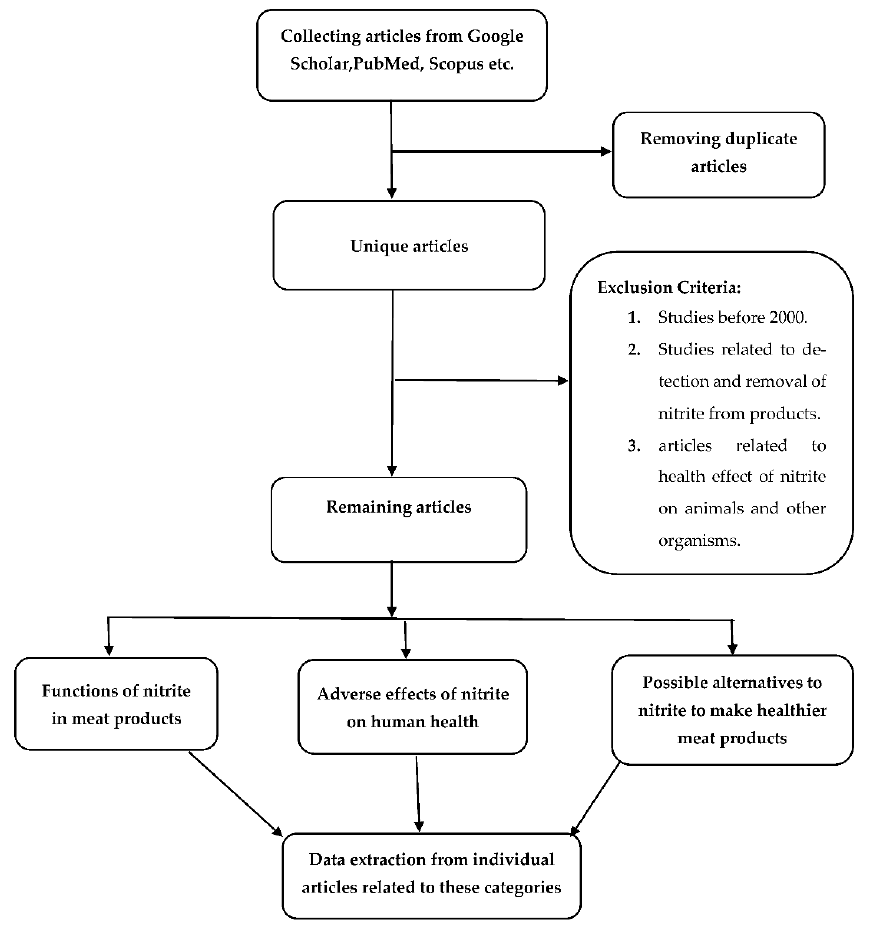
Figure 1. Flow diagram of the literature search and study choosing procedure.